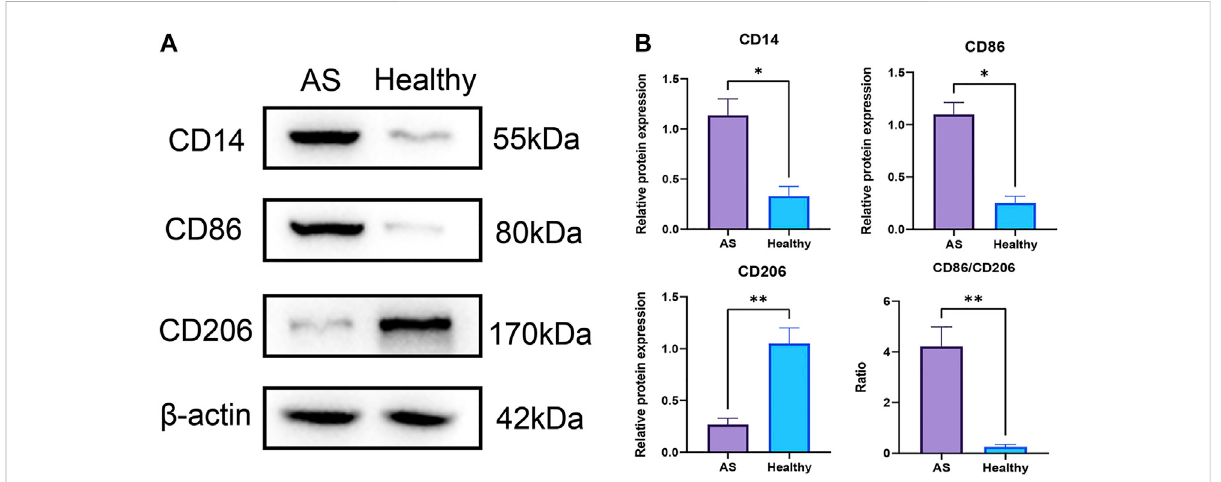
FIGURE 7 In fi ltrations ofmonocytes andM1-type macrophagesweresigni fi cantly increased inatherosclerotic tissues atpre-atheroma stage. (A) Western blots of the monocyte marker CD14, M1-type macrophage marker CD86, and M2-type macrophage marker CD206. (B) Differential analyses of the relative protein expression levels. **: p < 0.01; *: p <